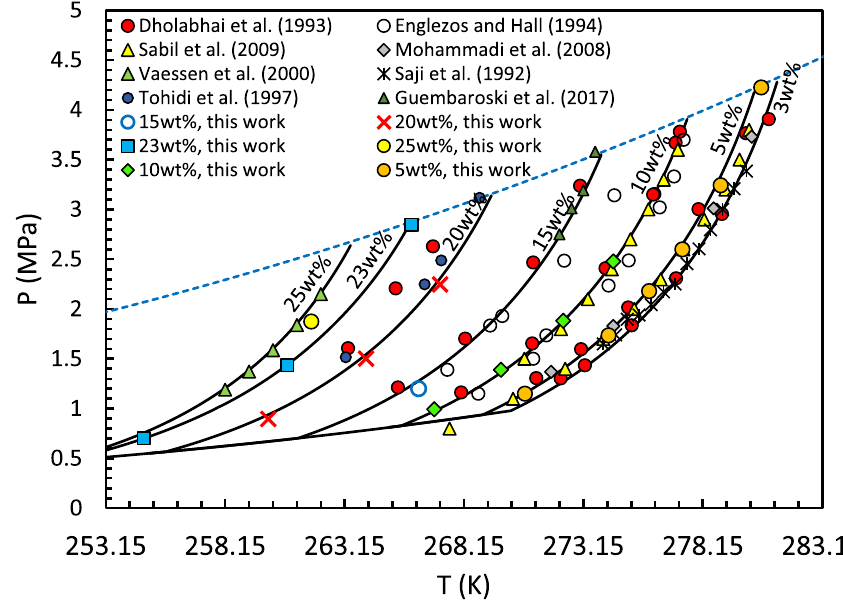
Fig. 4. Predicted and experimental hydrate stability of the CO 2 system in presence of aqueous sodium chloride solution in the VL w H region; Black lines: hydrate stability zone predicted using the CPA-EoS model using an aqueous mole fraction of 0.8; dotted blue lines: vapour – liquid locus of CO 2 (no water) using the CPA-EoS model.